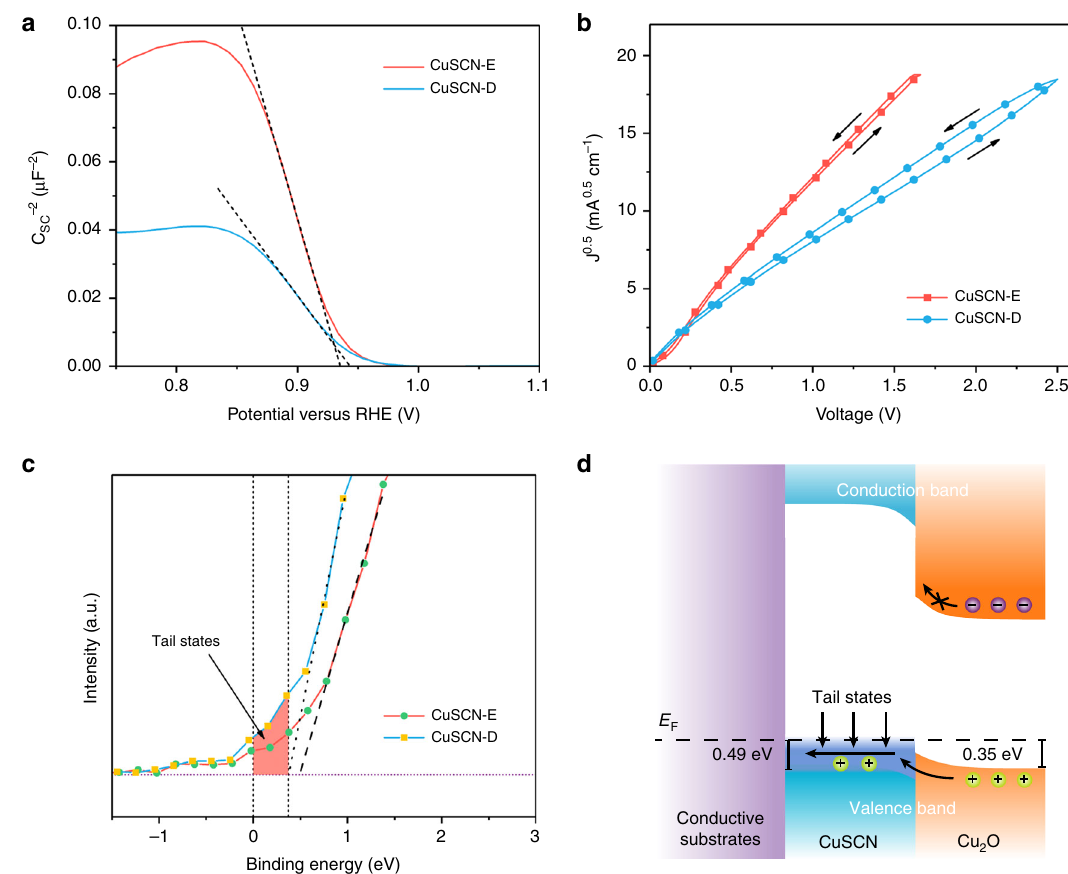
Fig. 3 Electronic properties of CuSCN layers and hole-transport mechanism. a Mott-Schottky plot of CuSCN layers tested in 1 M Na 2 SO 4 solution. b J 0.5 - V plots for CuSCN-based hole only devices. c Enlarged valence band spectra with shadowed area denoting the band-tail states. d Band energy diagrams showing the band-tail assisted hole transport between Cu 2 O and